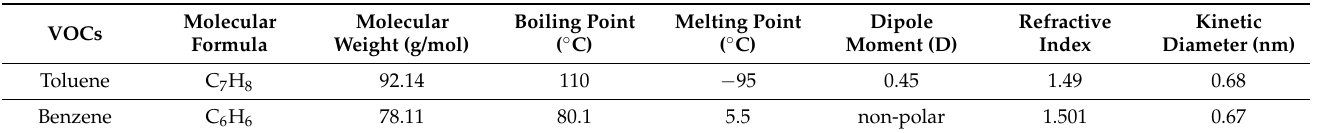
Table 1. The main properties of toluene and